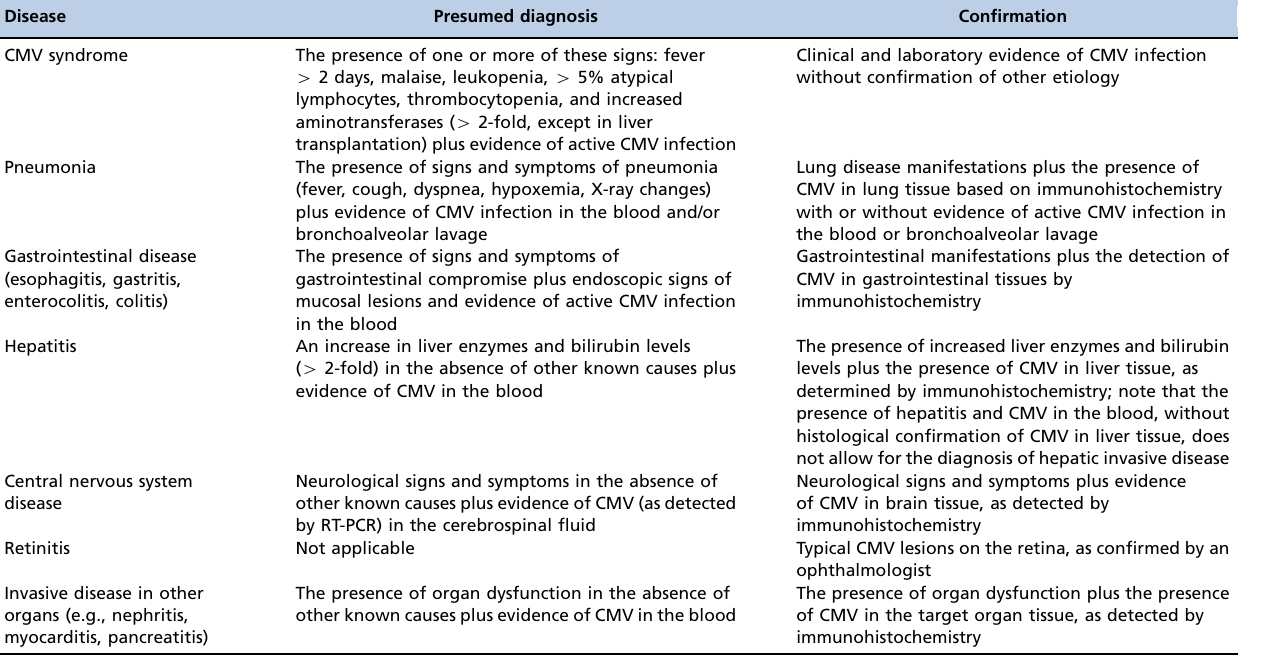
Table 1 - Definitions: CMV syndrome and disease affecting different organs (19–22) .